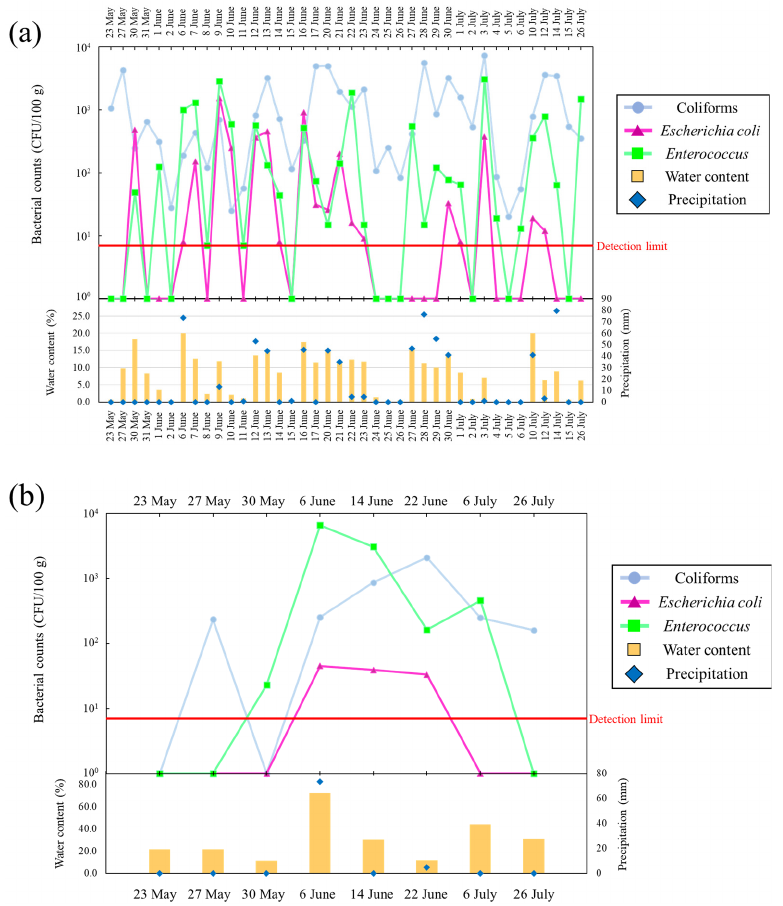
Figure 3. ( a ) Variation of Escherichia coli , coliform, and Enterococcus counts in supratidal top surface sand; water content; and precipitation at Shirahama Beach. ( b ) Variation of Escherichia coli , coliform, and Enterococcus counts in intertidal top surface sand; water content; and precipitation at Shirahama Beach. The investigations at Kizaki Beach and Shirahama Beach revealed that the bacterial counts in supratidal top surface sand were dependent on the water content of the sand a tt ributable to precipitation, and they varied markedly depending on the drying of the sand and the water supply associated with rainfall. Additionally, these results implied the presence of a time lag between the supply of water and bacterial growth. The time from desiccation to the growth of bacteria in soil after water supply was reported to vary de- pending on the state of the bacteria [26]. In beach fecal bacteria, the variation in water content between dry and wet conditions might have a similar e ff ect as that on soil bacteria. The temperature of the supratidal top surface sand fl uctuated dramatically between 21.5 °C and 54.0 °C, even within a single day (Tables S2 and S3). Even at temperatures exceed- ing 50 °C, the bacteria in the sand remained viable and repopulated when the conditions were favorable.